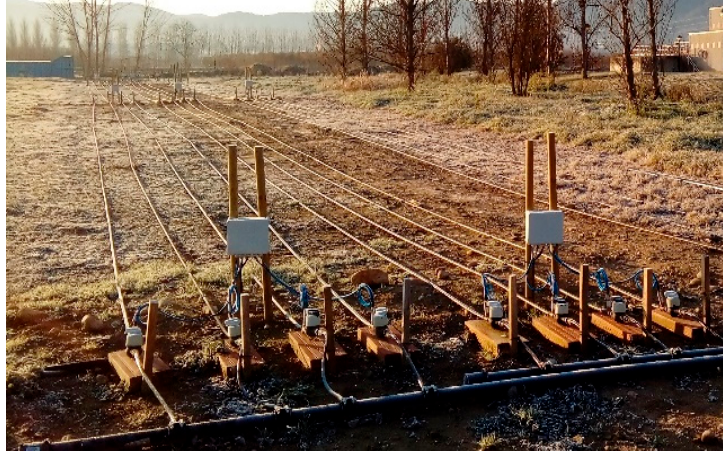
Figure 2. View of the pressure transducers and water meters of the irrigation subunits.